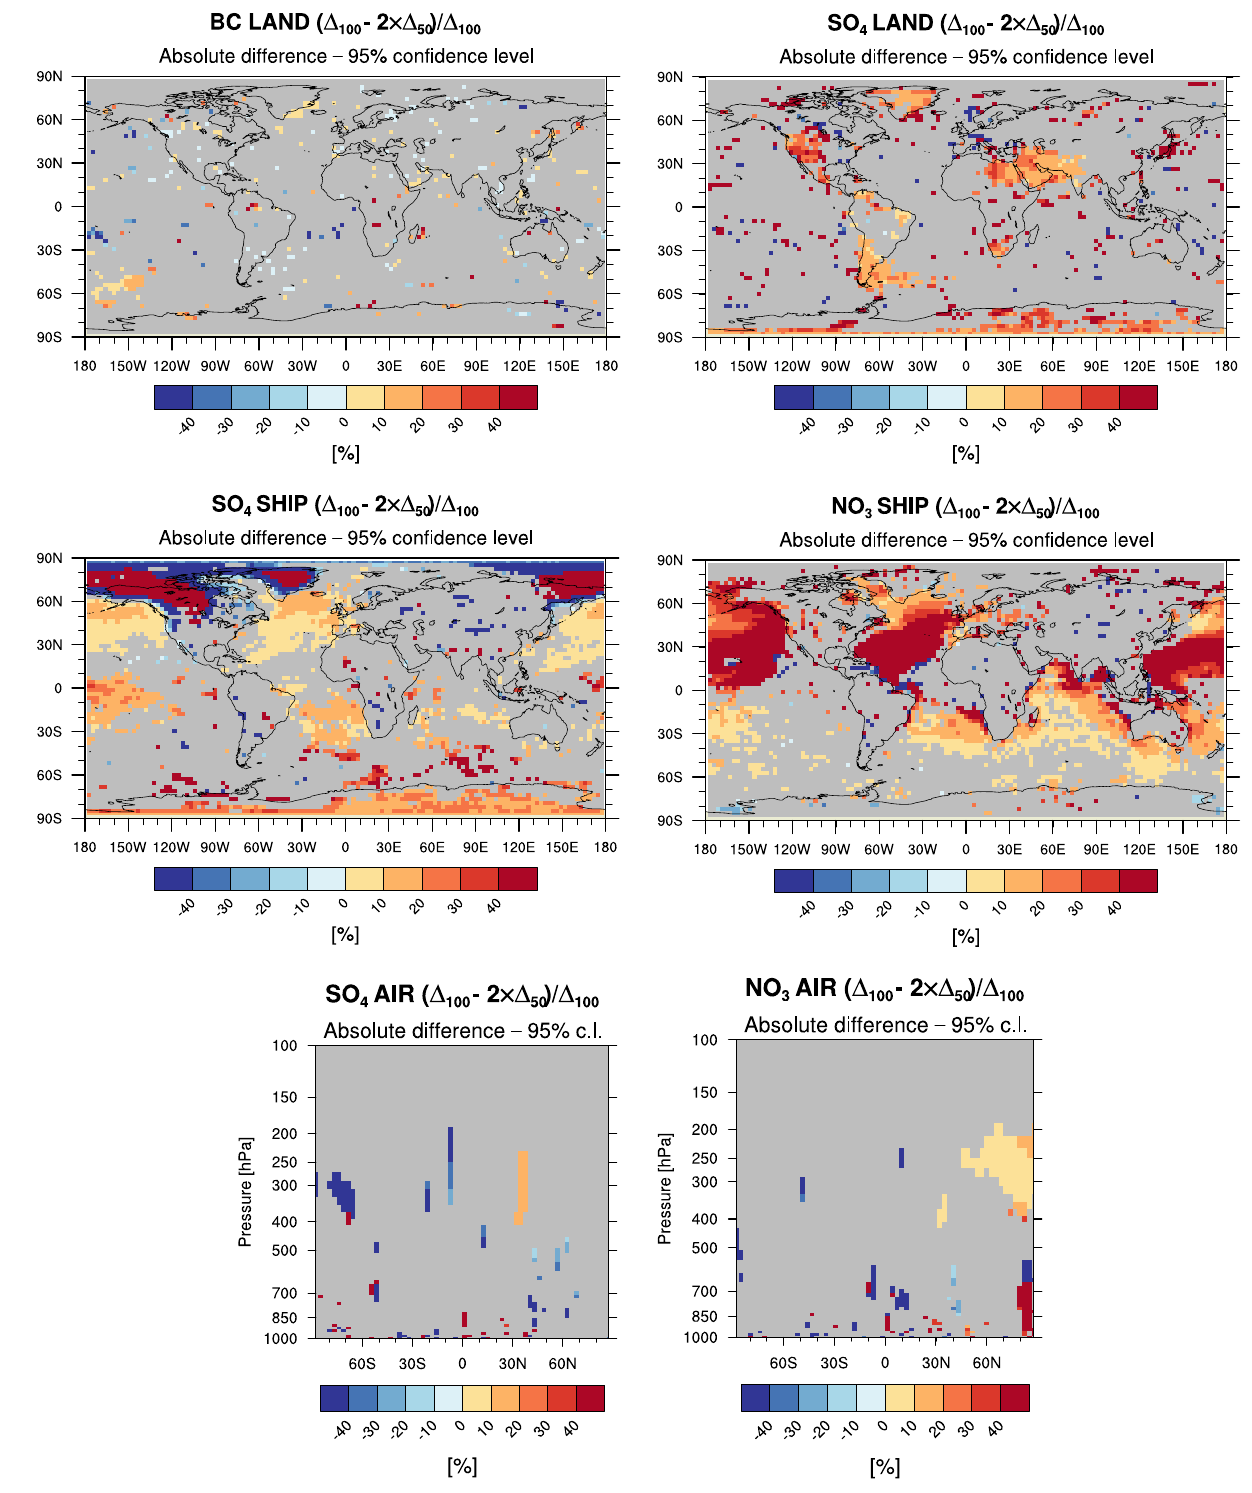
Fig. 13. Multi-year average (1996–2005) of the relative difference (1 100 − 2 × 1 50 )/1 100 , quantifying the effect of non-linearities on the estimated impact of the different transport sectors on aerosol concentrations. Selected species for land transport (top, surface-level concentration), shipping (middle, surface-level concentration) and aviation (bottom, zonally averaged concentration) are plotted. Grid points where the difference is not statistically significant according to a uni-variate t test (5% error probability) are masked out in